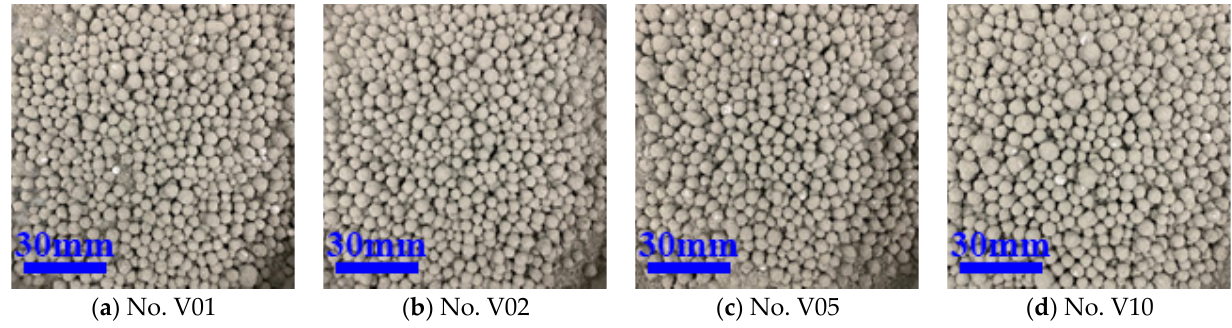
Figure 4. The exposure of CSLA after VAE emulsion treatment.